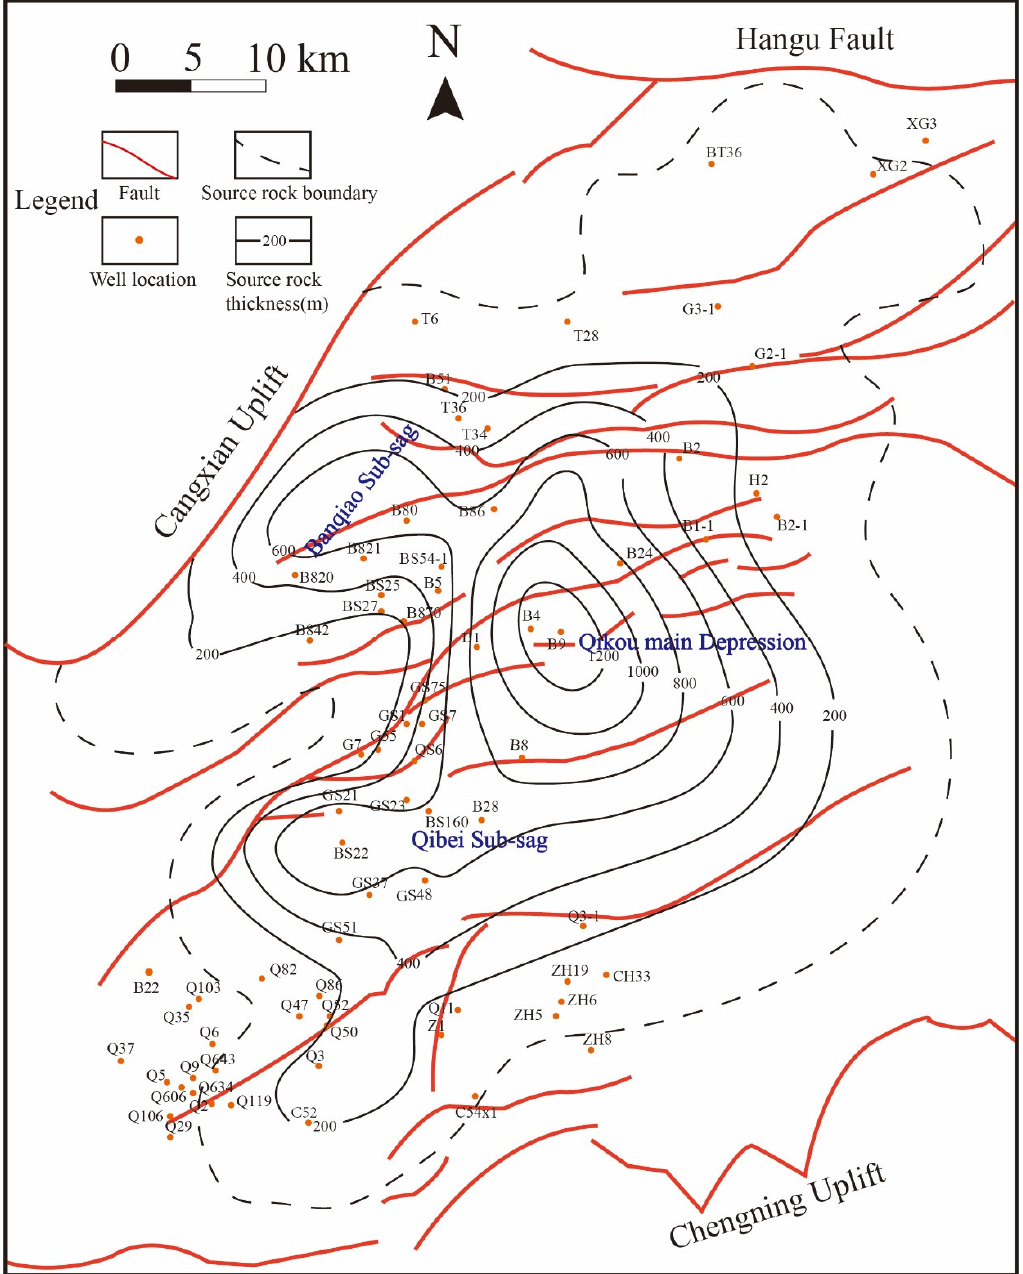
Figure 3. Contour map of Mbr 3 source rocks’ thickness.